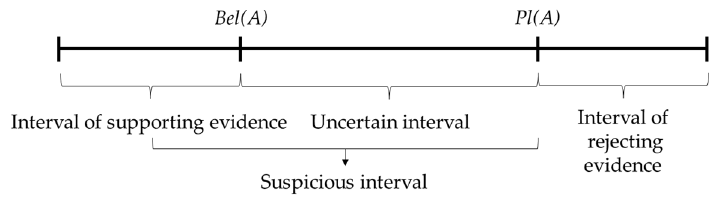
Figure 1. Uncertain relationship in D-S evidence theory.